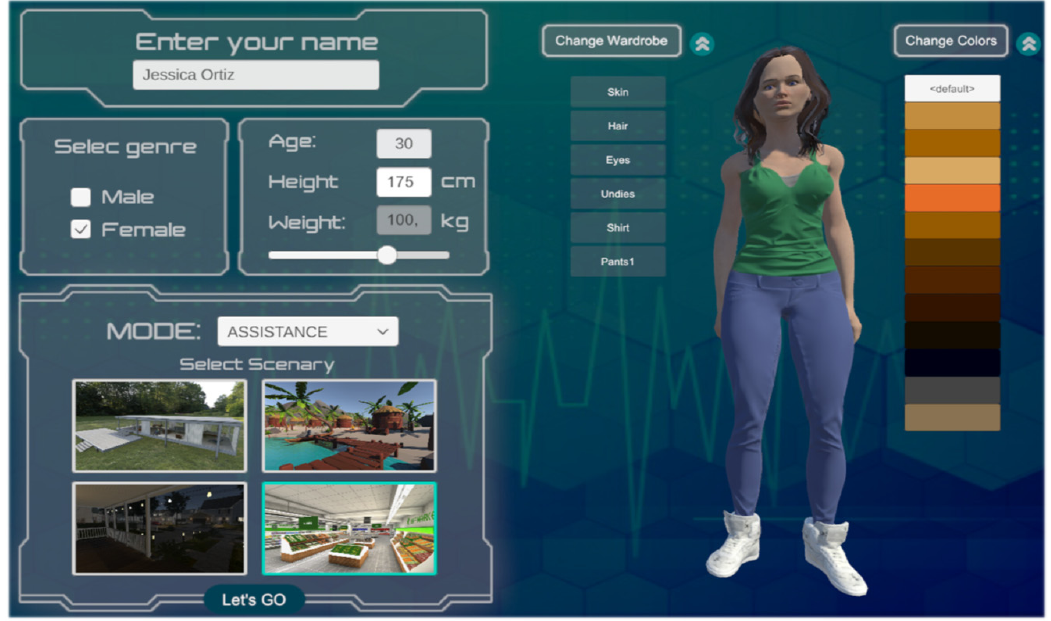
Figure 15. Scene configuration of the simulator environment for robotic assistance (initial scene). Different virtual scenarios showing for the activities of daily living were developed to carry out autonomous assistance tasks. Figure 16 shows the virtualized scenarios, for which two types of visual art were considered: (i) High Definition Render Pipeline (HDRP), in which advanced visual optimization and lighting techniques were implemented to emulate the visual stimuli as faithfully as possible, as perceived in the real world; and (ii) Low poly style, which uses a small number of polygons in 3D models, with the purpose of seeking the abstraction of the elements and that the form takes over the design in such a way that a minimalist appearance is generated that encourages the user’s creativity to a certain extent during the execution of the